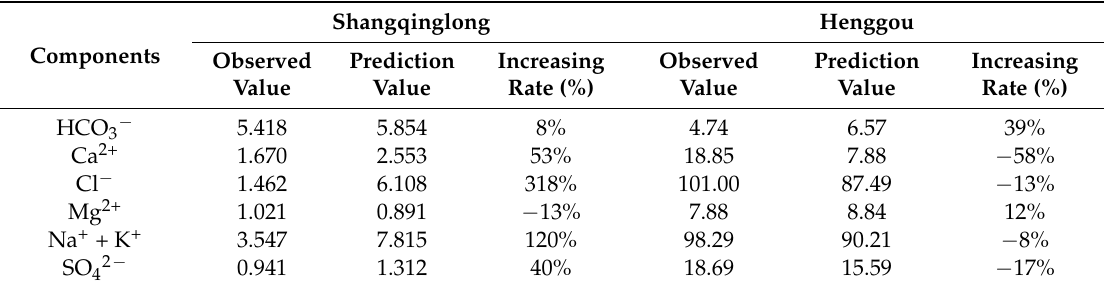
Table 3. Prediction of chemical components in karst groundwater in focal area